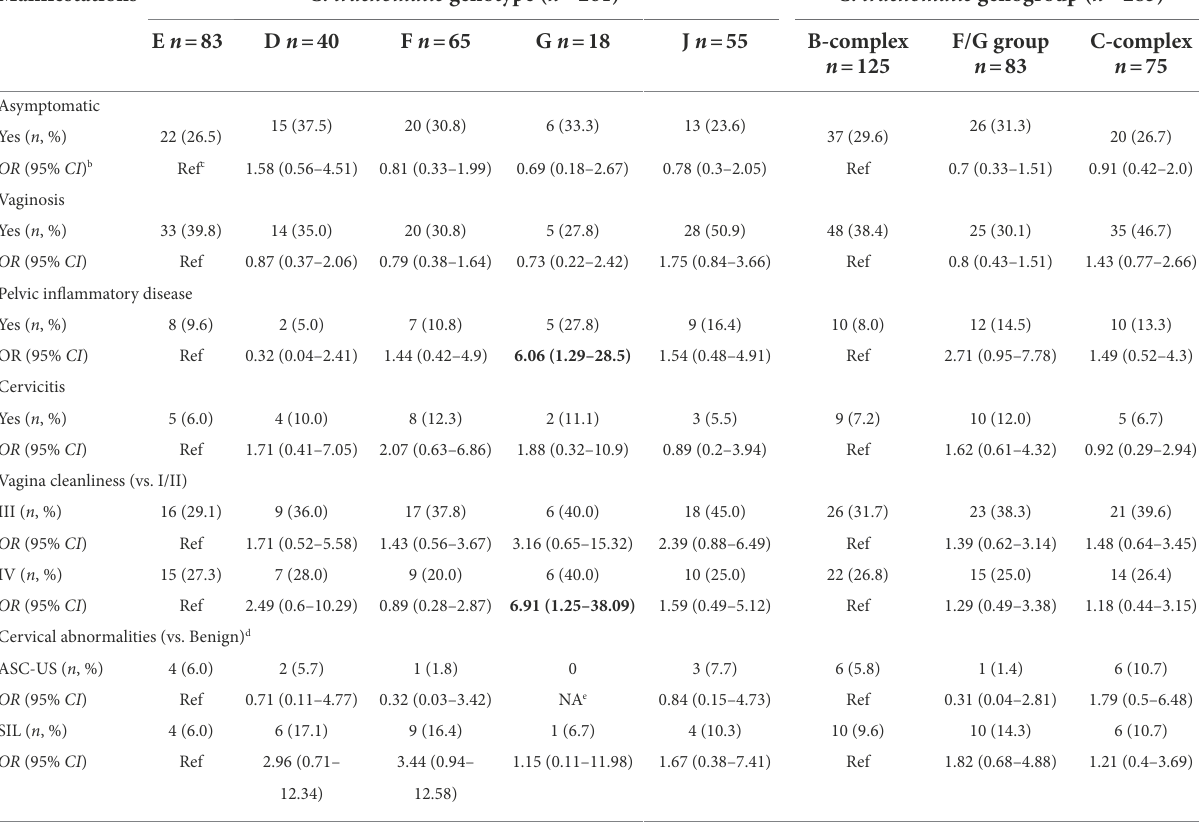
TABLE 4 Relationships of clinical manifestations to C. trachomatis genotypes in 283 women infected with single-genotype of C. trachomatis . Manifestations C. trachomatis genotype ( n = 261) a C. trachomatis genogroup ( n =